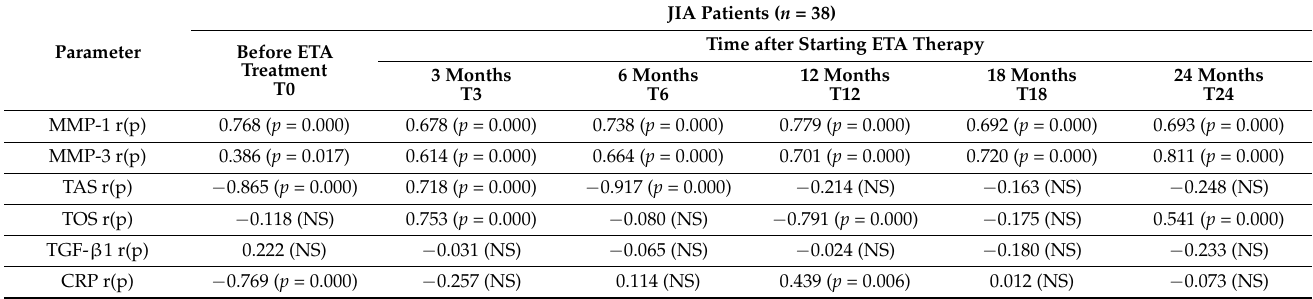
Table 3. Correlation analysis between plasma GAGs and MMP-1, MMP-3, TAS, TOS, TGF- β 1, and CRP levels in JIA